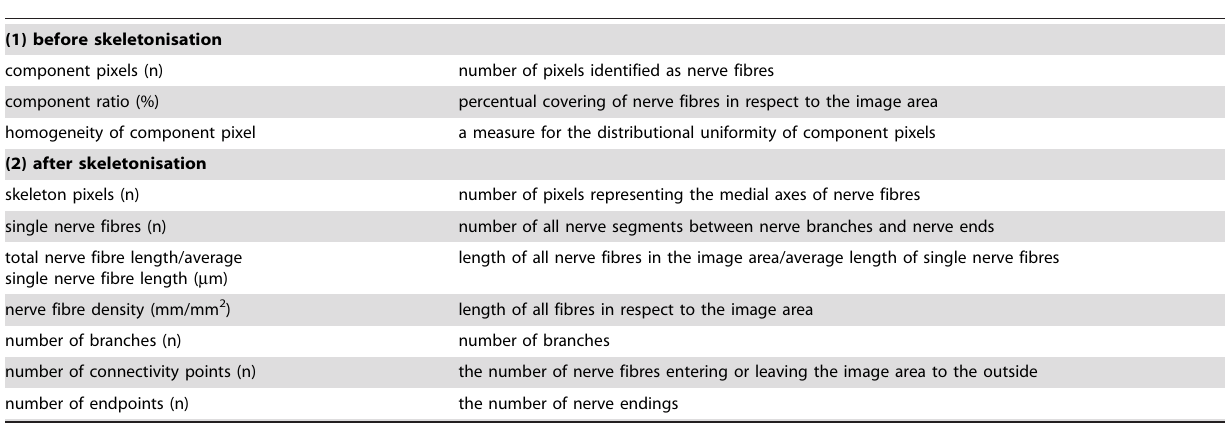
Table 3. Parameters of automatic quantification of SBP structures.